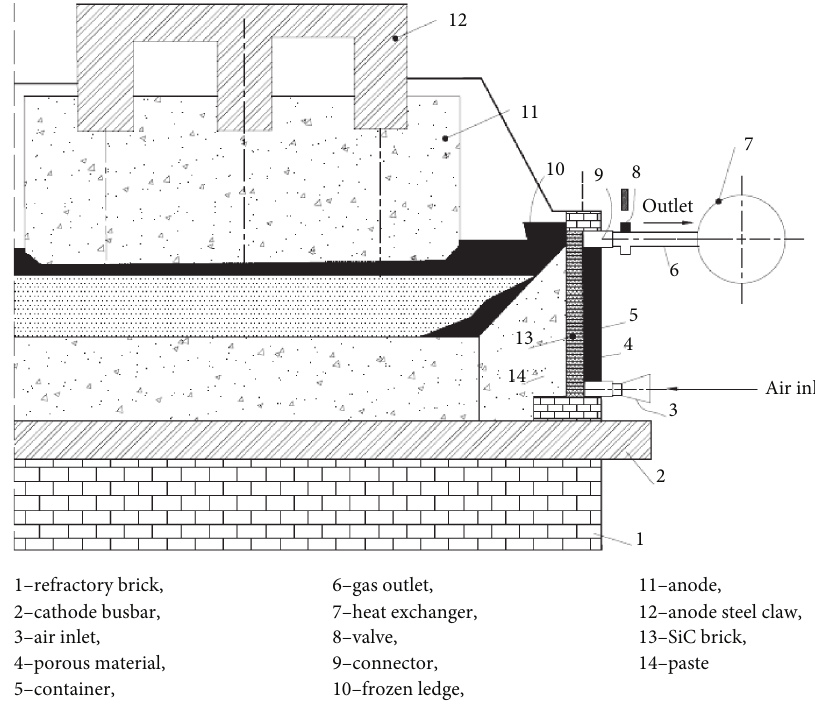
Figure 2: A type of heat-exchanging aluminum reduction cell developed by Pechiney Aluminum